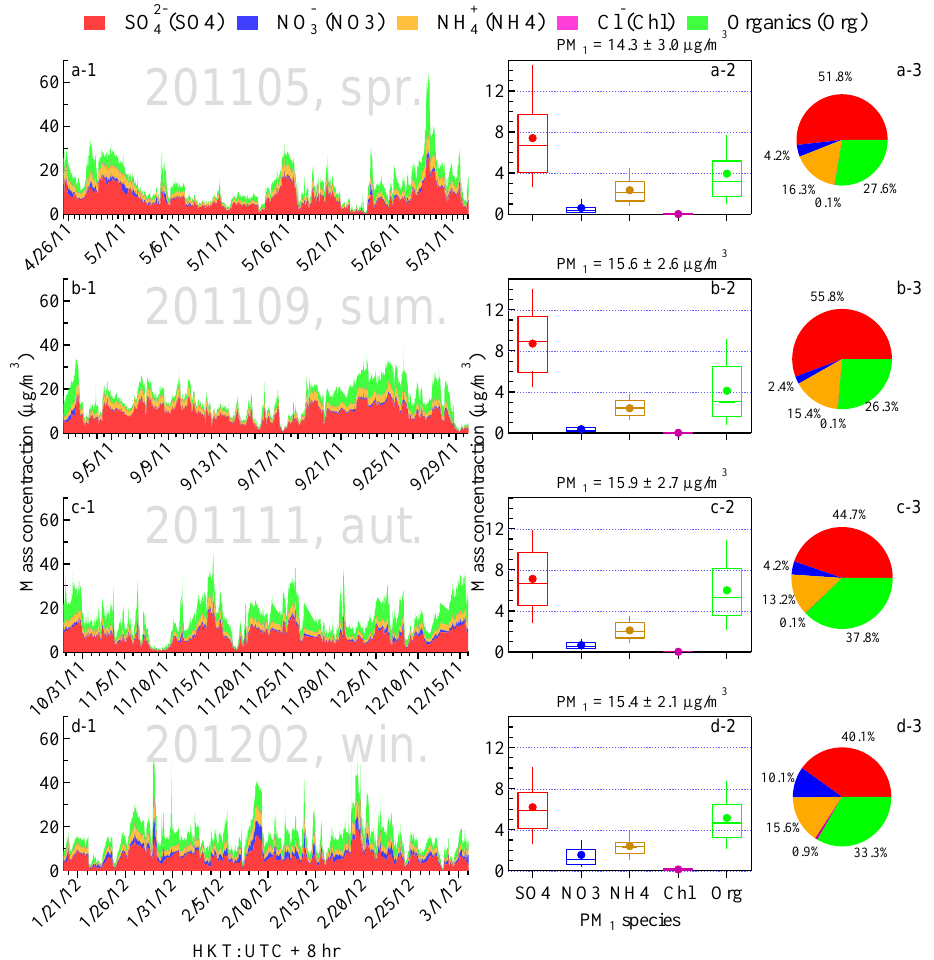
Figure 1. Summary of species (sulfate, nitrate, ammonium, chloride, and organics) in NR-PM 1 in the four months. x-1: time series; x-2: monthly mean (dot), median (bar), 25% and 75% percentiles (box), and 10% and 90% percentiles (whiskers), x-3: monthly fraction (x-3), where “x” is “a” for spring (201105), “b” for summer (201109), “c” for autumn (201111), and “d” for winter (201202). Monthly averaged total NR-PM 1 concentrations are shown above the x-2 panels with 1 standard deviation. The area of a pie chart is proportional to the NR-PM 1 concentration.